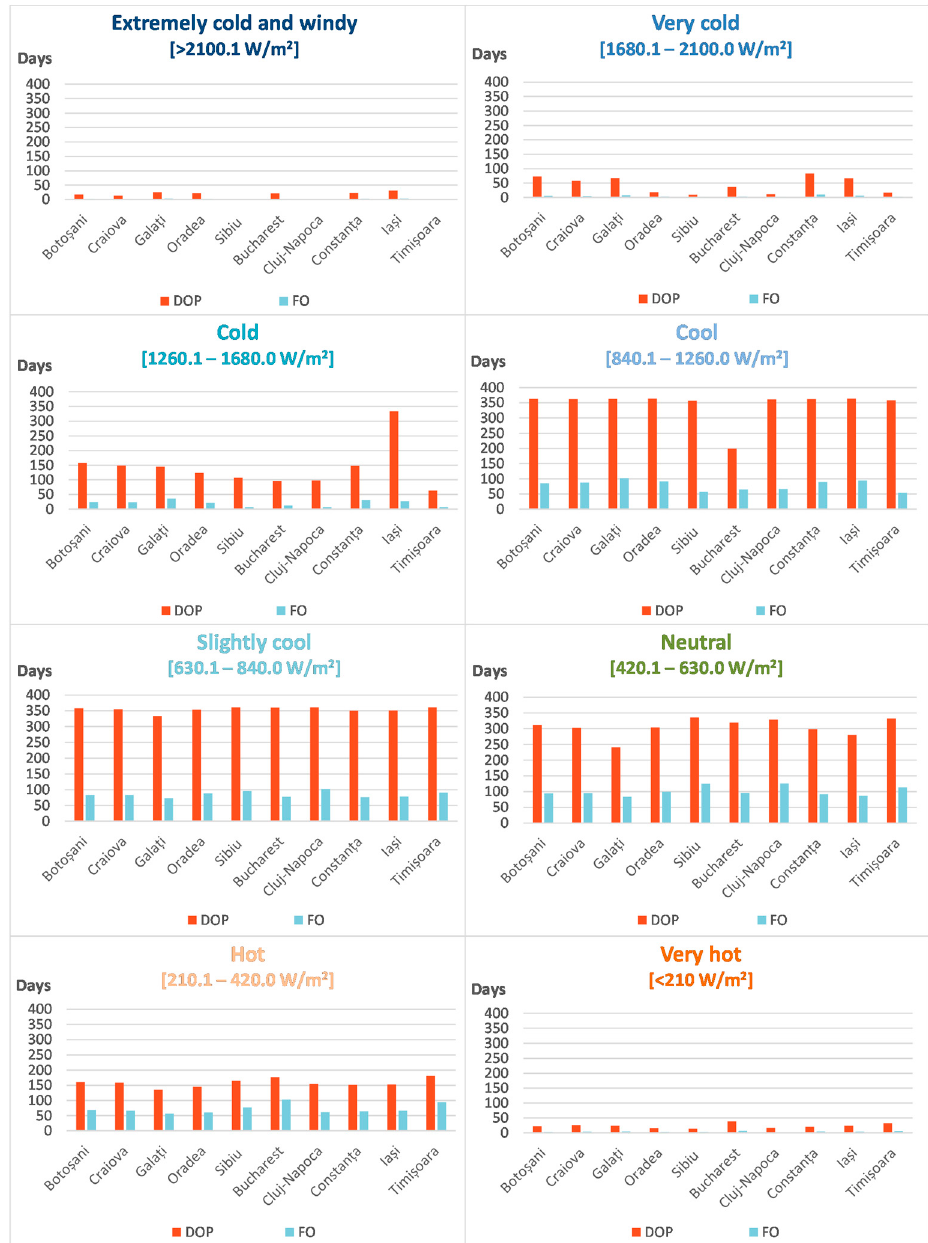
Figure 8. DOP and FO for the H index by thermal sensations classes and weather stations (number of days).